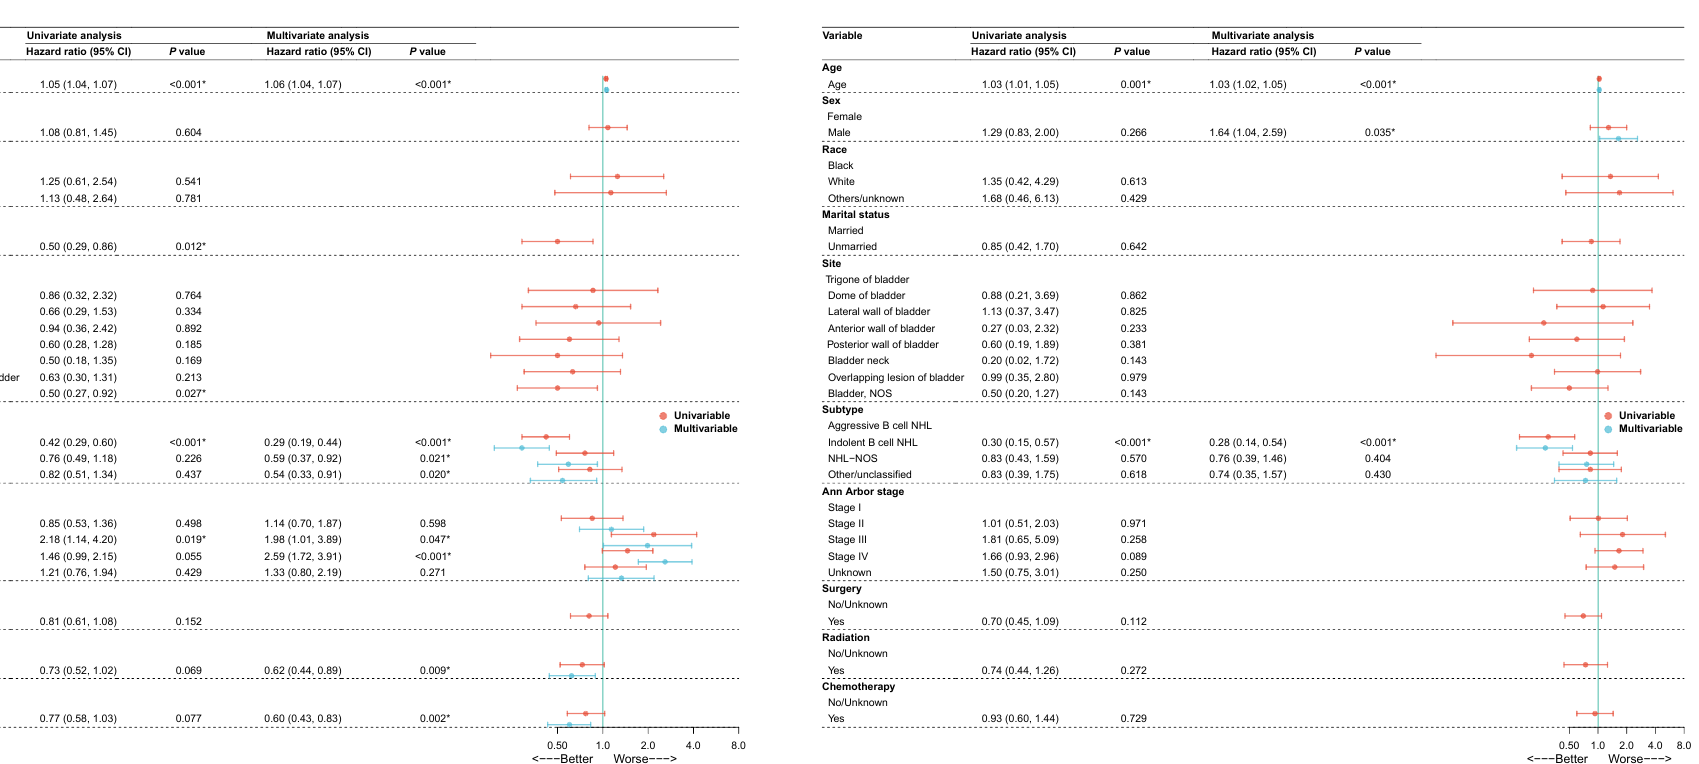
Figure 2. The Univariate and Multivariate Cox regression analysis in training cohort (N = 283) of patients with primary bladder lymphoma for OS ( A ) and CSS ( B ). OS, overall survival; CSS, cancer-specific survival. * p <